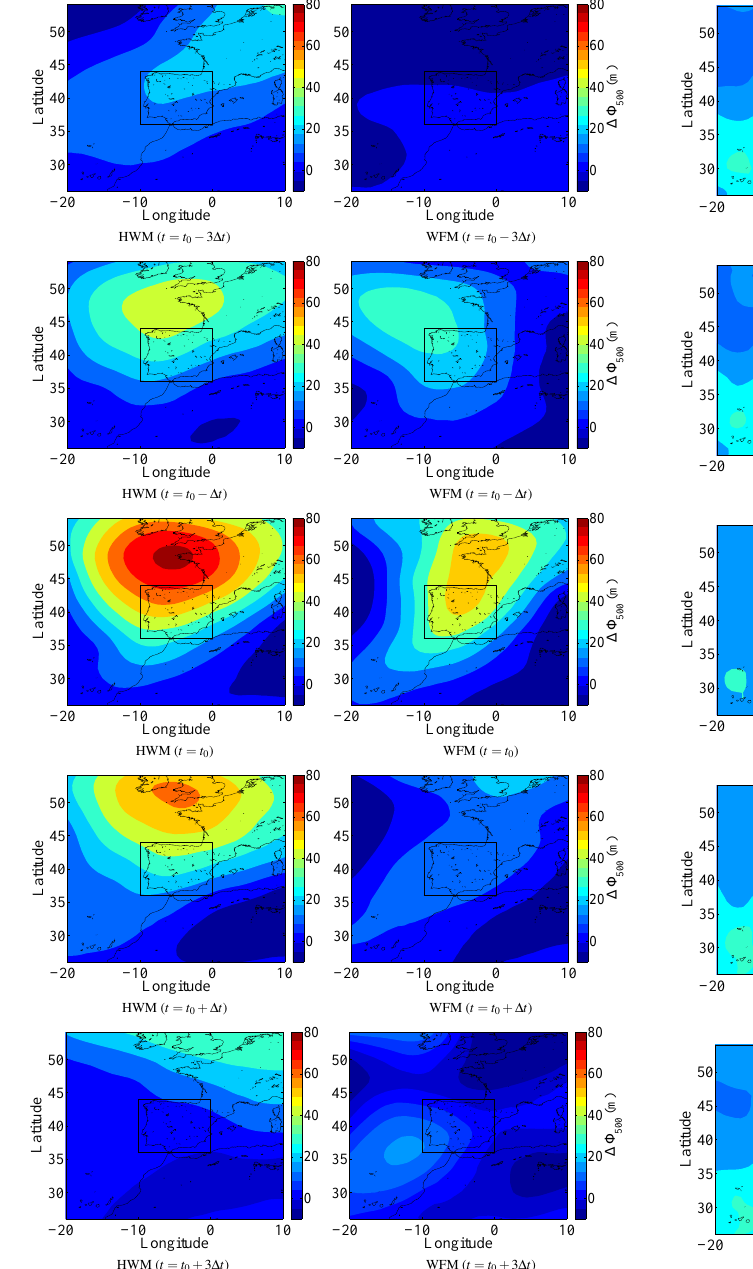
Figure 6. Composites over the Iberian Peninsula of the 500-hPa geopotential anomaly ( (cid:49)(cid:56) 500 ) for HWM (left column) and WFM (right column) wildfires at time t 0 − 3 (cid:49)t (first row from top), t 0 − (cid:49)t (second row from top), t 0 (third row from top), t 0 + (cid:49)t (fourth row from top) and t 0 + 3 (cid:49)t (fifth row from top). The composites are computed using the BA diagnostic.